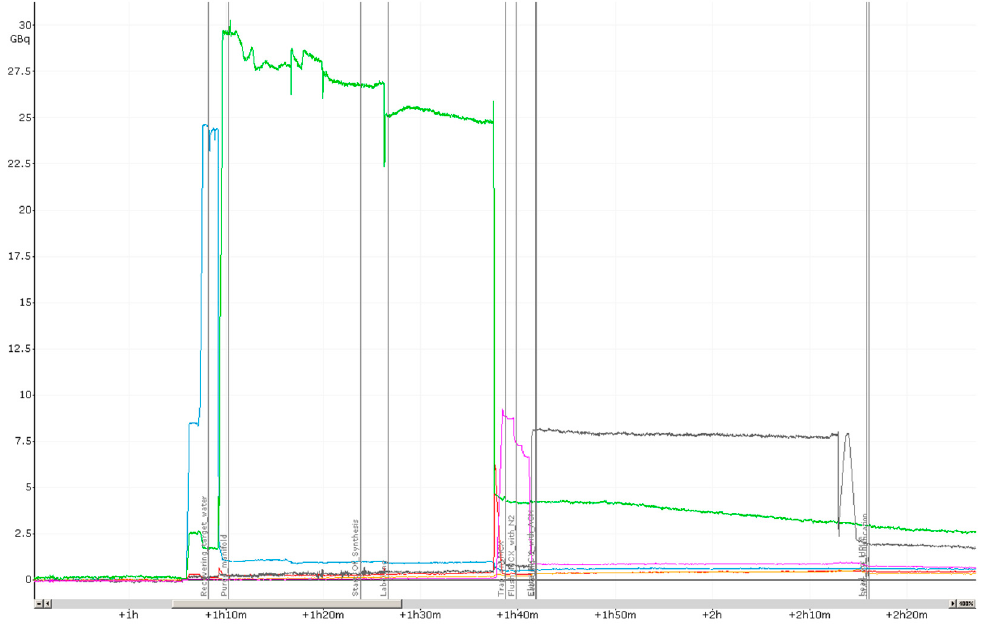
Figure 4. Activity trails during a typical production of [ 18 F]PSMA-1007 by the two-step procedure on Trasis AllInOne radiosynthesiser.